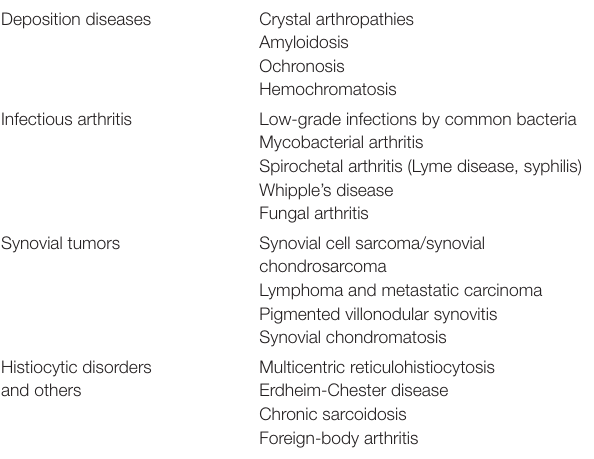
TABLE 1 | Clinical utility of synovial biopsy in differential